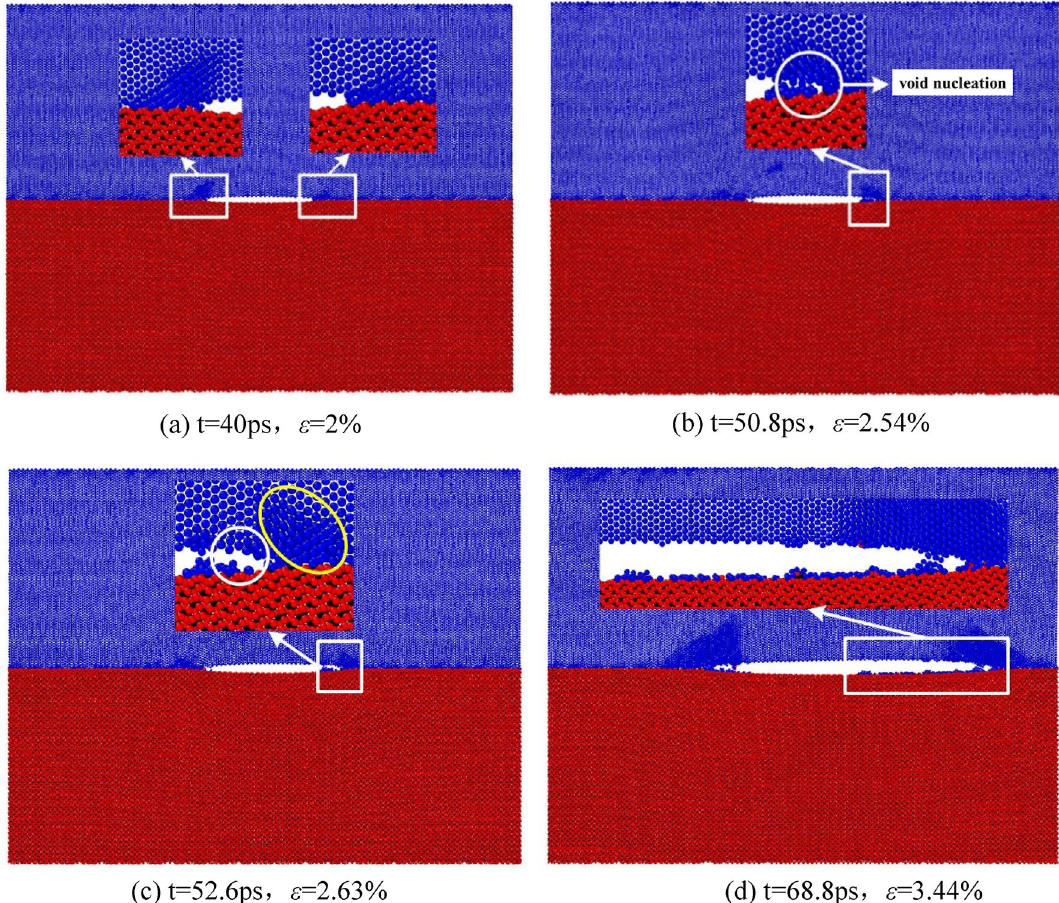
Figure 12. Atomic accumulation, hole initiation, hole growth and bonding of C–Fe terminal